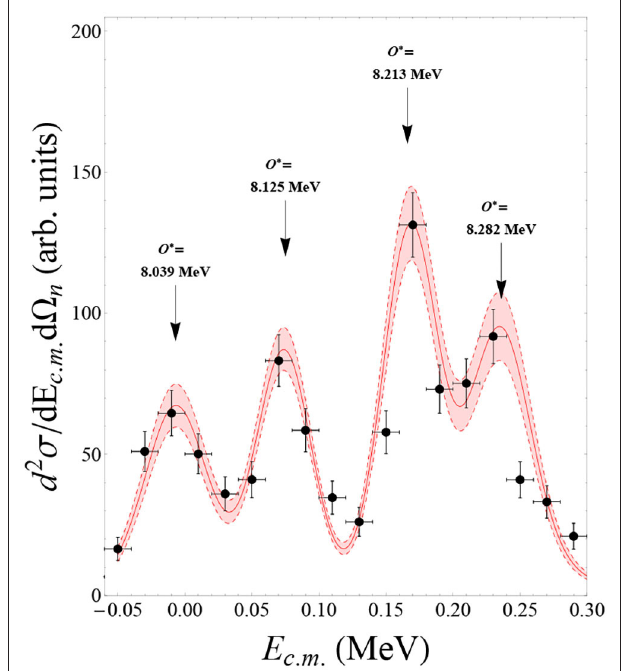
FIGURE 11 | Integrated QF two-body cross section for the 17 O(n, α ) 14 C reaction in arbitrary units. Experimental data are displayed with black points. The n- 17 O relative energy binning are reported with the horizontal error bars, while the vertical ones represent the statistical and integration uncertainties. The red line is the best fit to the data calculated with the modified R-matrix